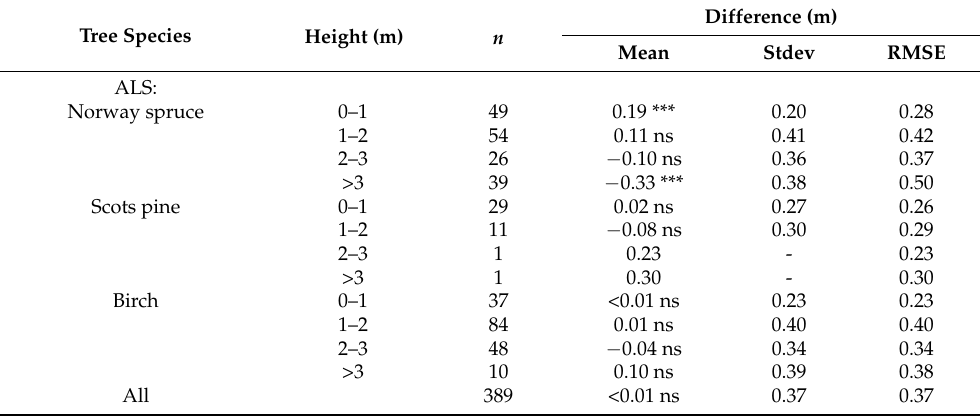
Table 9. Results of leave-one-out cross validation of the models in Equation (4) (Table 7) based on differences between predicted and observed tree height for the different 3D remotely sensed datasets, tree species, and tree height classes ( n =